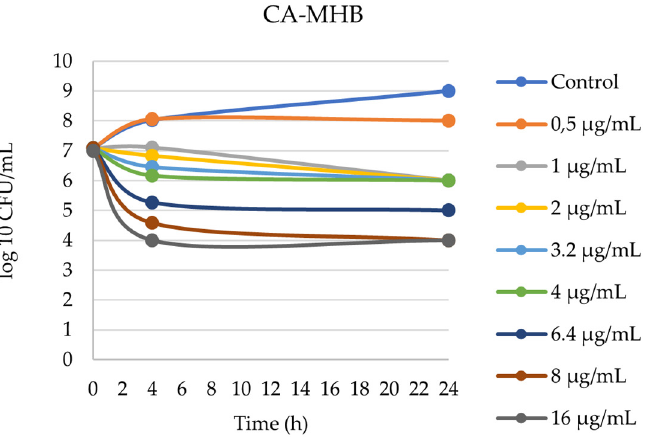
Figure 3. In vitro killing–time curves of florfenicol against S. suis 96 strain in three different media (synovial fluid, plasma, CA-MHB). Table 2. PK/PD breakpoints determined from the sigmoidal E max inhibition equation in porcine syn- ovial Fluid, plasma and CA-MHB.